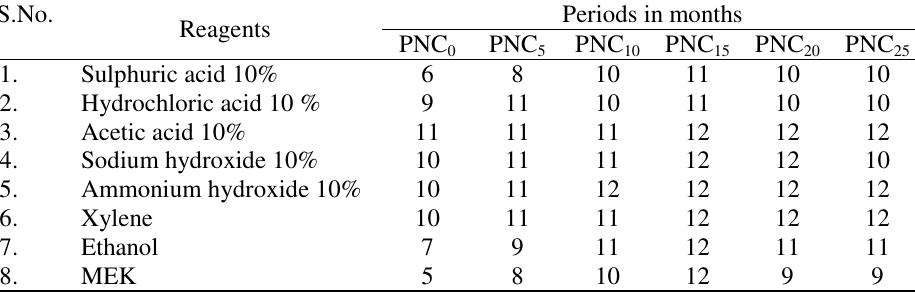
Table 3 . Comparative study of acid, alkali and solvent resistance of modified epoxy and CTPB blend films a cured at 150 0 C showing the period after first effect